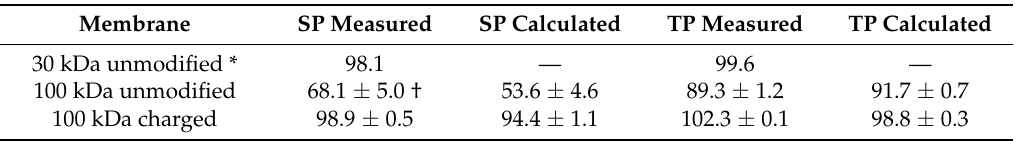
Table 4. Measured versus calculated percentage recovery of serum protein (SP) and true protein (TP) in the product retentate (R 2 ) for the manufacture of MPC from raw skim milk by ultrafiltration and